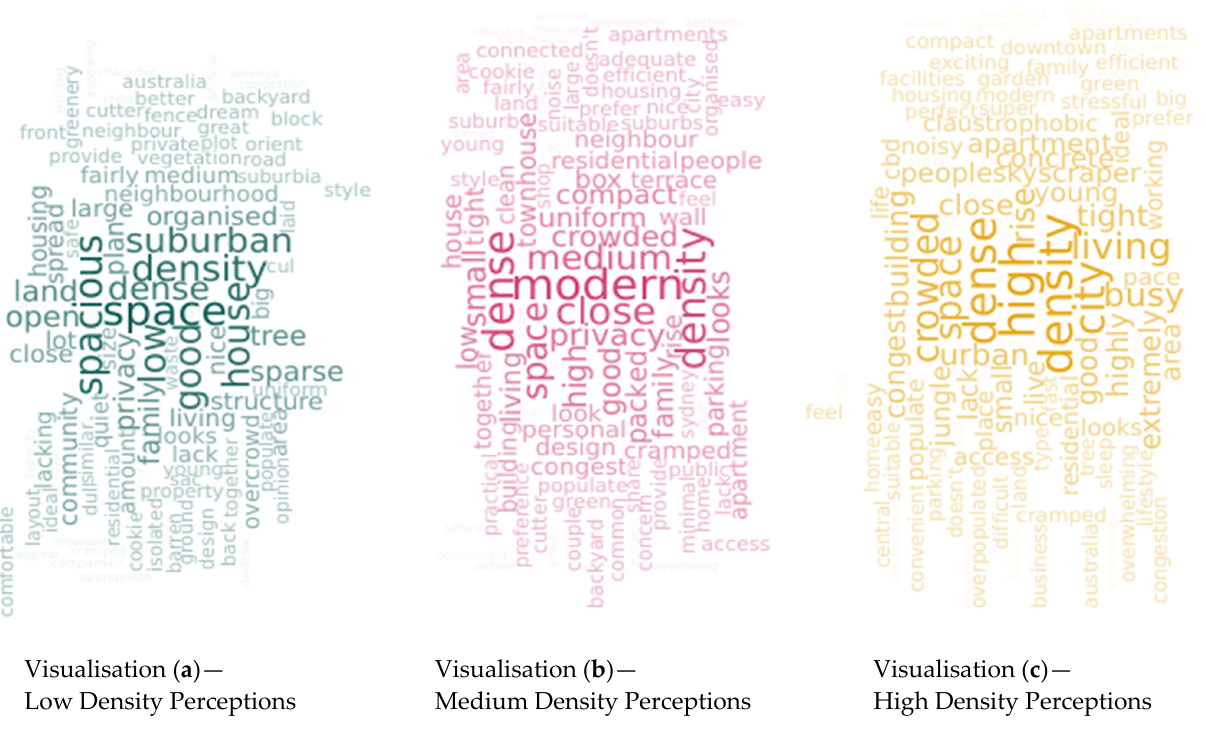
Figure 4. The visualisation of the frequency of words in the transcriptions representing different concepts. ( a ) Low-density Perceptions; ( b ) medium-density perceptions; ( c ) high-density perceptions.